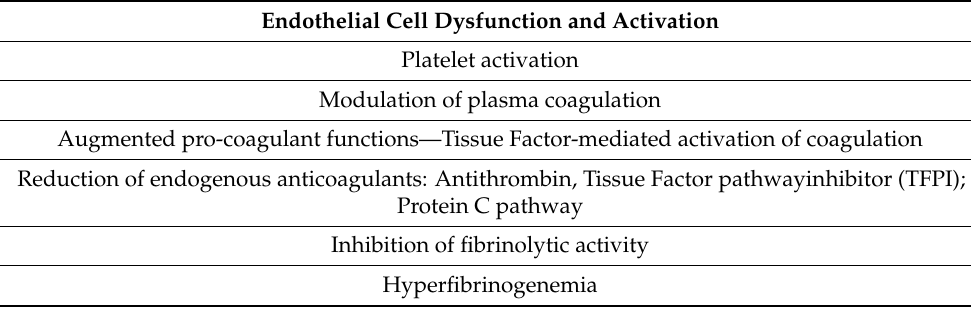
Table 1. Mechanisms of inflammatory-induced thrombosis.